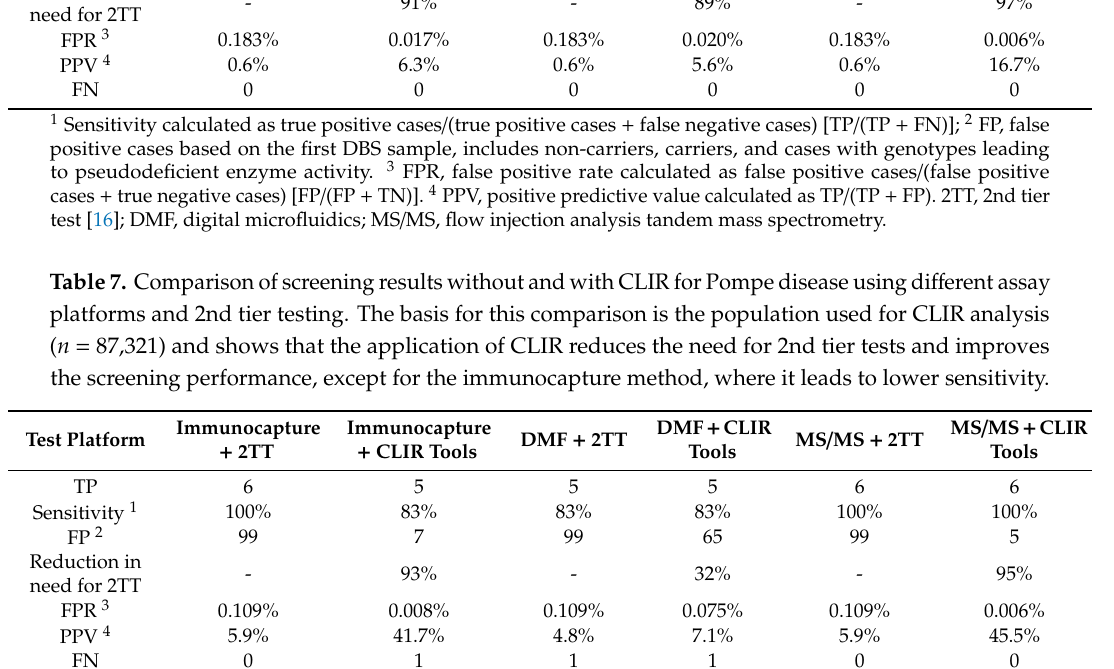
1 Sensitivity calculated as true positive cases / (true positive cases + false negative cases) [TP / (TP + FN)]; 2 FP, false positive cases based on the first DBS sample, includes non-carriers, carriers, and cases with genotypes leading to pseudodeficient enzyme activity. 3 FPR, false positive rate calculated as false positive cases / (false positive cases + true negative cases) [FP / (FP + TN)]. 4 PPV, positive predictive value calculated as TP / (TP + FP). 2TT, 2nd